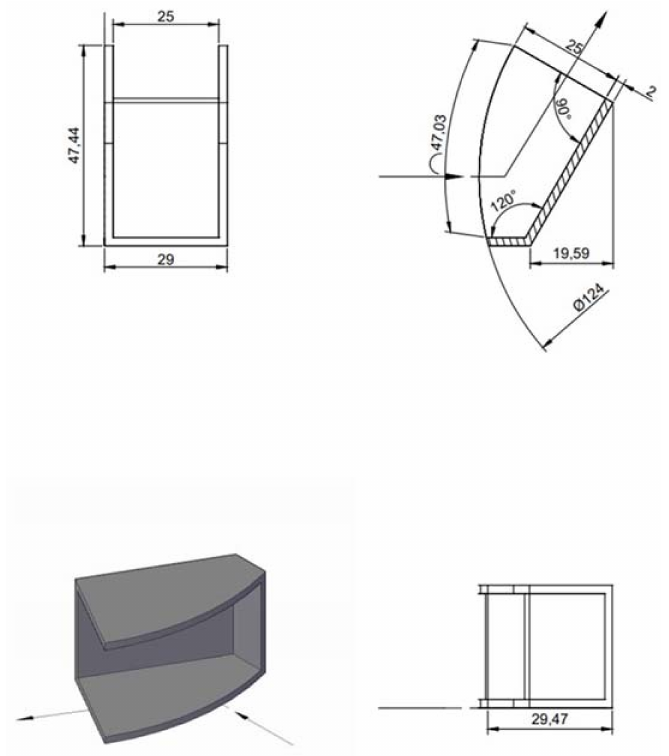
Figure 2. Directional deflector for the OW sedimentation